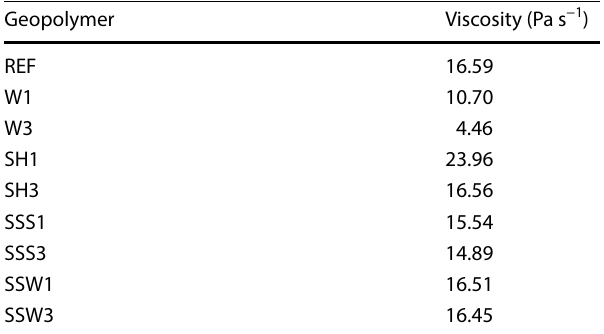
Table 3 Viscosity of the tested metakaolin geopolymers at 25 °C and 1